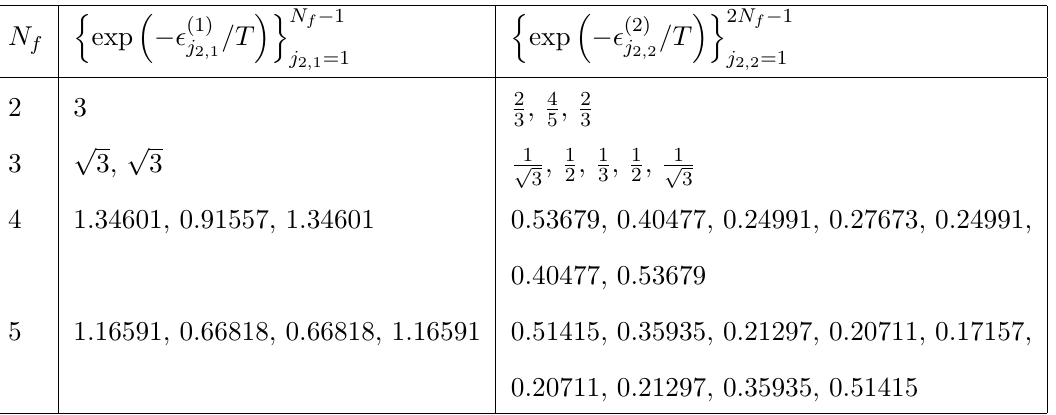
Table 1 . Asymptotic solution ( j (cid:21) j ! 1 ) of auxiliary modes ( (cid:15) ( m ) 2 (cid:20) N f (cid:20) 5 derived numerically from eqs. (2.13) with (cid:15) ( m )